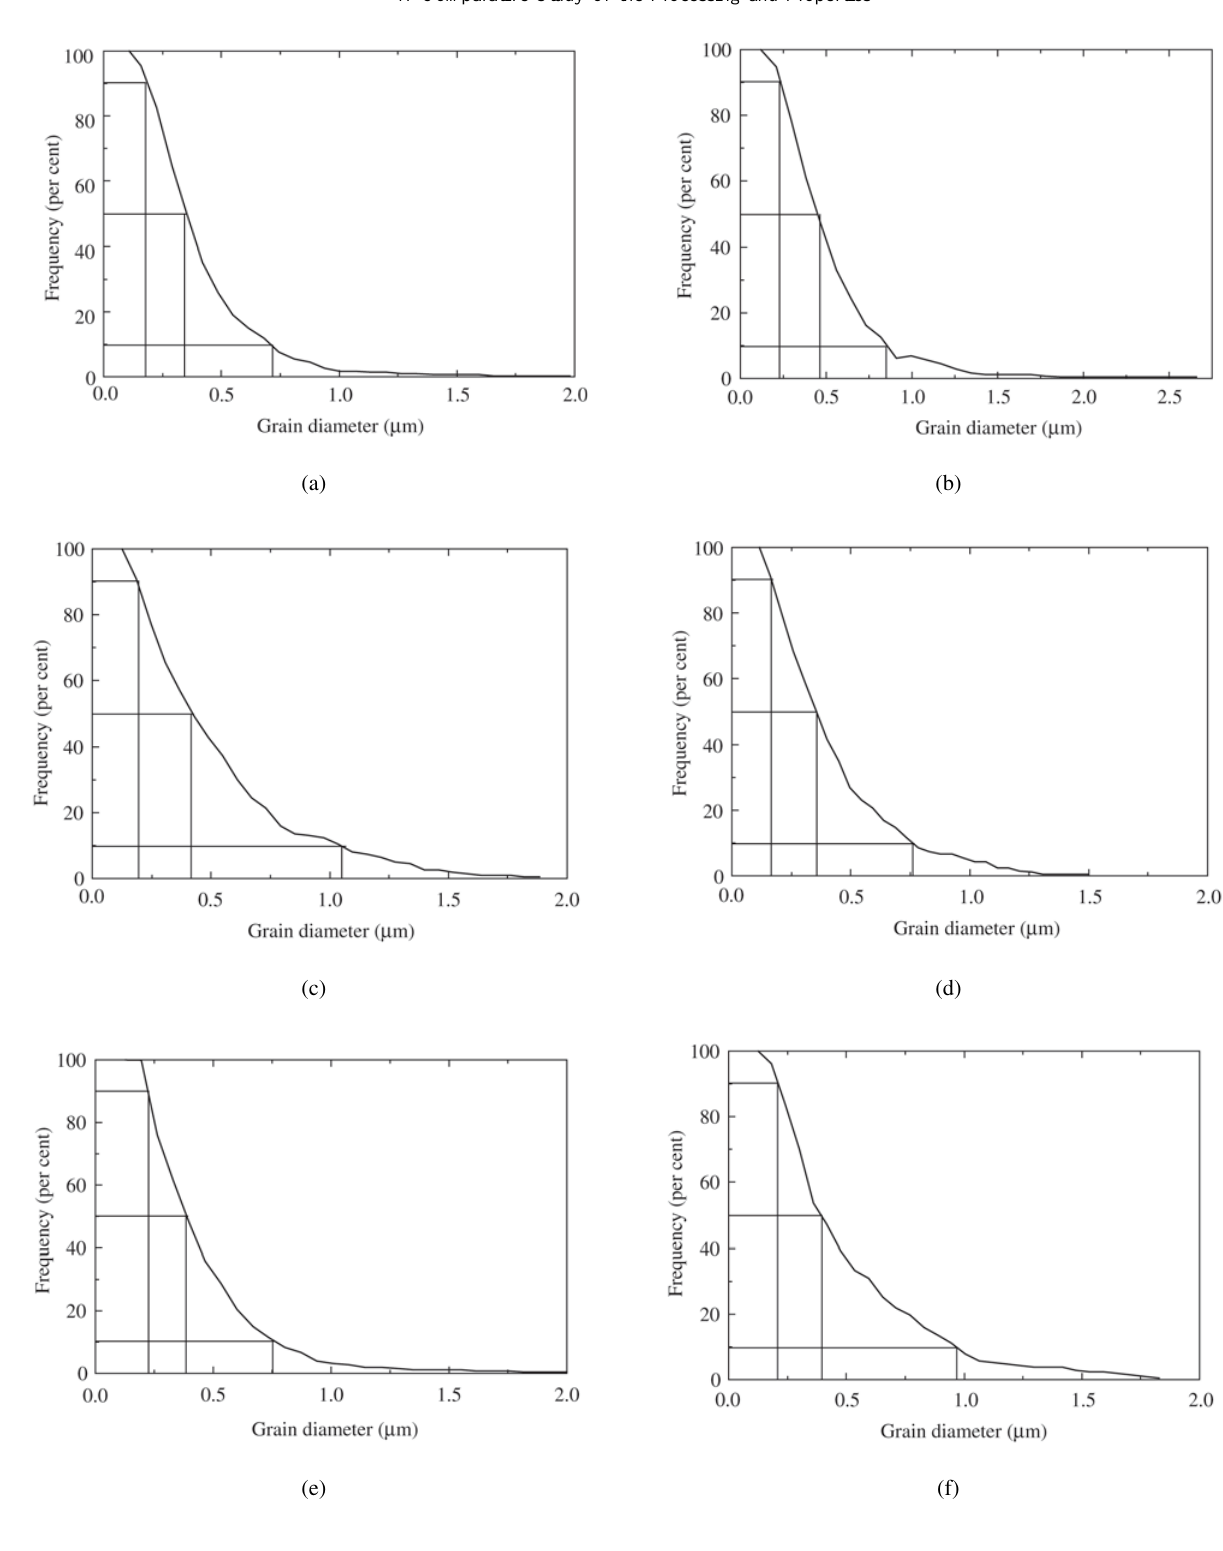
Figure 4. Grain size distributions revealed by the correlation between grain diameter and frequency for sintered SNY14 (a, b and c) and SNTR14 (d, e and f) samples. The samples were sintered at 1800 °C for 30 (a and d), 60 (b and e) and 240 (c and f)